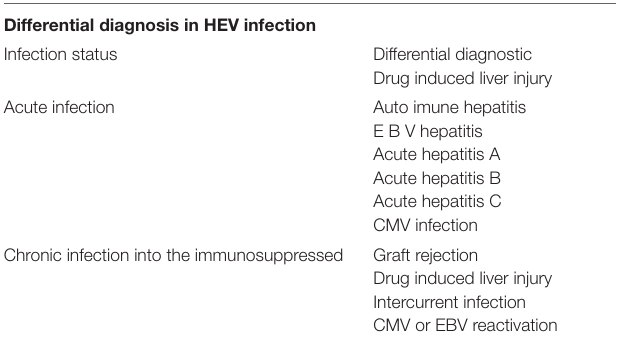
TABLE 3 | Differential diagnosis of acute and chronic HEV